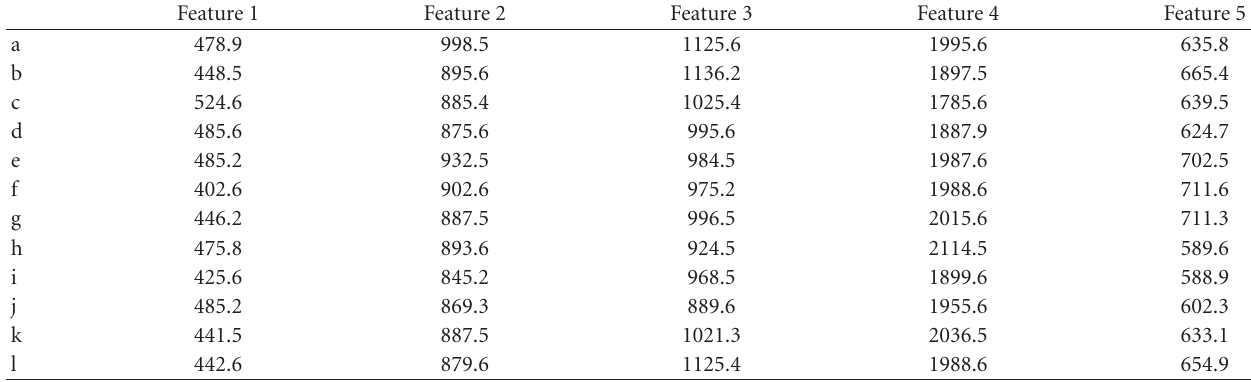
Table 7: Energy distribution surface features in scattered data interpolation